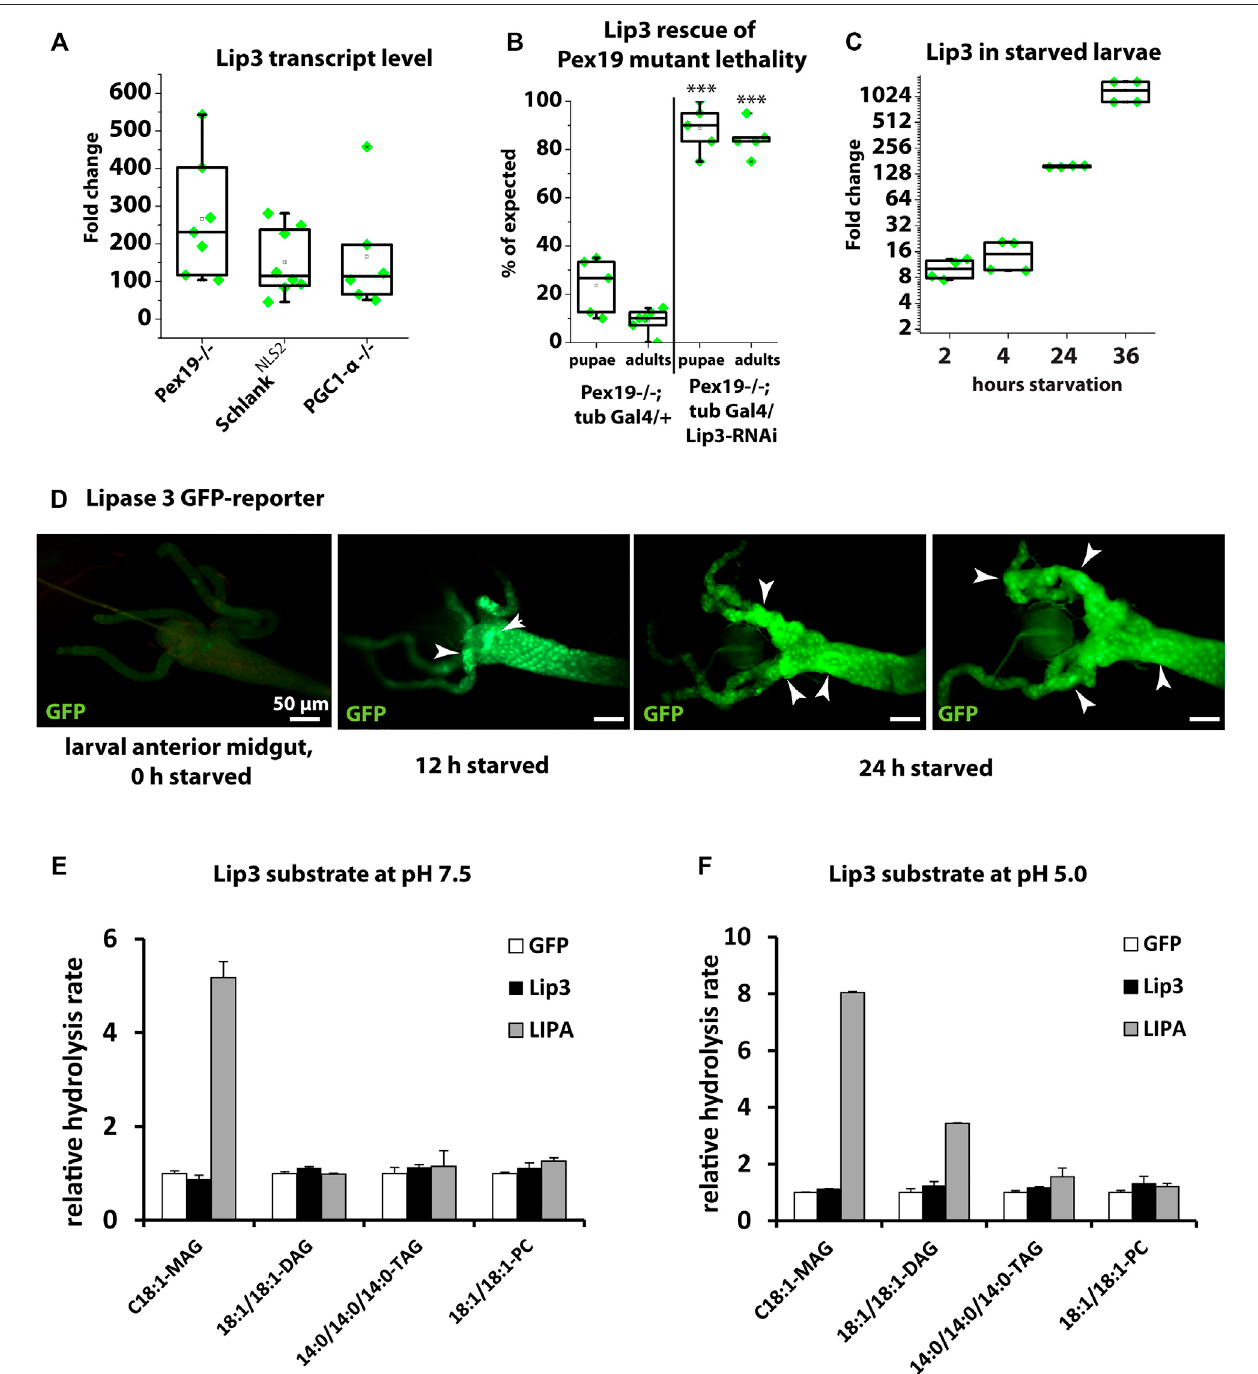
FIGURE 1 | (A) Quantitative real-time PCR of Lip3 transcript of Pex19, Schlank-NLS2 and PGC1- α mutant larvae normalized to rp49 and actin-5c ( Δ Cq) housekeepinggenesandwildtypic(w-)controllarvae( ΔΔ Cq). (B) Rateofpupaeandadultsdevelopingfrom1stinstarlarvae.Genotypesarew*;pex19 − / − ;tubulin-Gal4/ + and w*; pex19 − / − ; tubulin-Gal4/UAS-Lip3-RNAi. (C) Quantitative real-time PCR of Lip3 expression in wildtypic starved larvae, normalized to rp49 and actin-5c housekeeping genes and relative to fed larvae. (D) Lip3 promoter-GFP reporter in anterior midguts of fed, 12 h starved, and 24 h starved early 3rd instar larvae. (E, F) Relative hydrolysis rate of Lip3 and LIPA (GFP as control) expressed in mammalian cell culture under neutral conditions (pH 7.5; E) and under acidic conditions (pH 5.0; F). Asterisks represent *** p < 0.001.